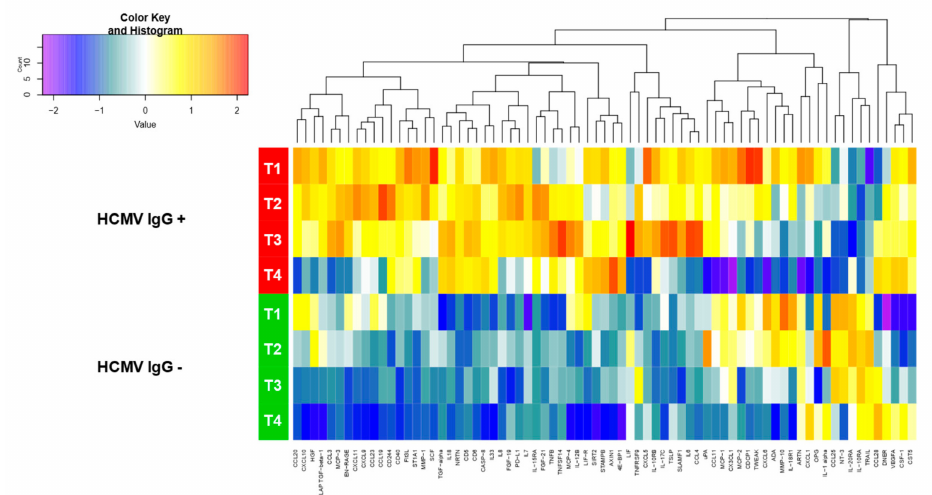
Figure 2. Heat map of longitudinal cytokine levels in milk whey of two index cases (mother 4, human cytomegalovirus (HCMV) IgG-seropositive, and mother 5, HCMV IgG-seronegative); obtained by Proximity Extension Assay technology; four time ranges at weeks 2-3 (T1), 4-5 (T2), 6-7 (T3), and 8-9 (T4), after